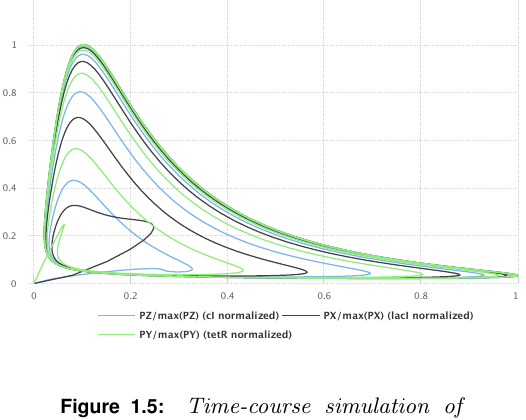
Figure 1.5: Time-course simulation of the repressilator. Normalized lacI , tetR and cI in phase-plane. Simulation with SED-ML web tools [2].